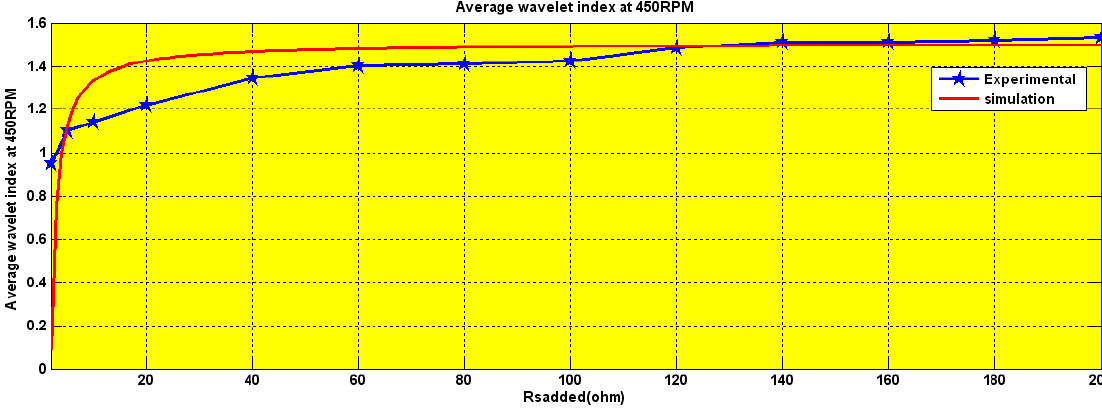
Figure 20. Experimental and simulation Wavelet index Ohm at 450